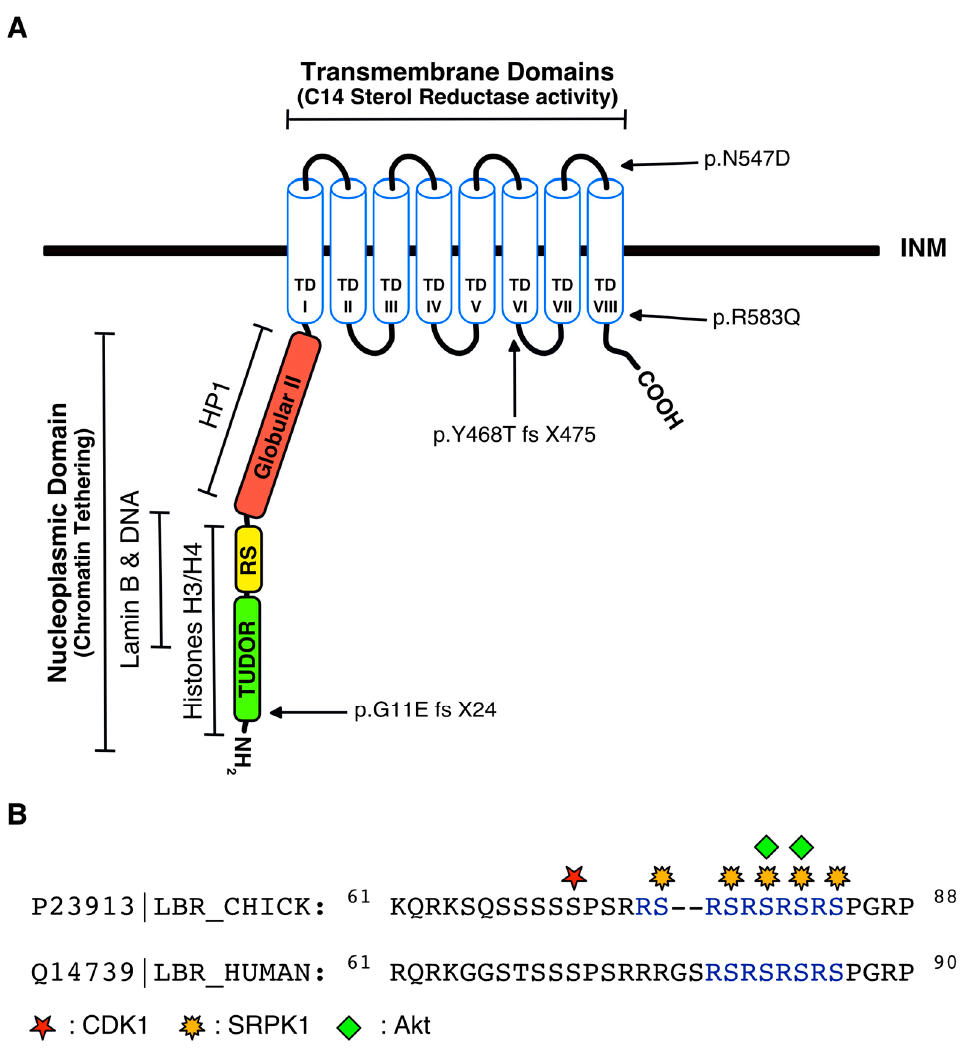
Figure 1. ( A ) Schematic illustration of full-length LBR. Green, yellow and red boxes correspond to tudor (Met 1 to Phe 60), arginine/serine (RS; Arg 61 to Arg 89) and second globular regions (Pro 90 to Gly 211 in human LBR), respectively, that compose the hydrophilic nucleoplasmic domain, while TDI–TDVIII represent the eight transmembrane domains where the sterol reductase activity of LBR resides. The binding sites for histones H3/H4, DNA, lamin B and HP1 are illustrated. Arrows indicate the positions of the missense mutations R583Q and N547D that result in the production of full-length LBR which lacks sterol reductase activity, and the frame shift mutations p.G11E fs X24 and p.Y468T fs X475 that create premature stop codons in codons 24 and 475, respectively; ( B ) Alignment of the chicken and human RS domain sequences. Numbers indicate the number of amino acid residues from the N -terminus. Red, yellow and green marks indicate the serine residues in chicken LBR phosphorylated by CDK1, SRPK1 and Akt kinases, respectively.